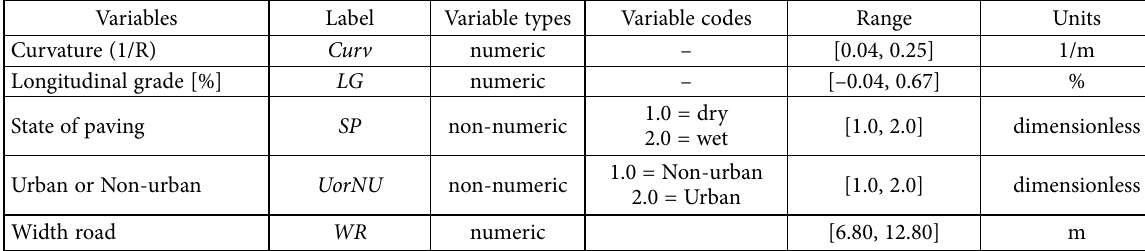
Table 2. Variables used in the cluster analysis